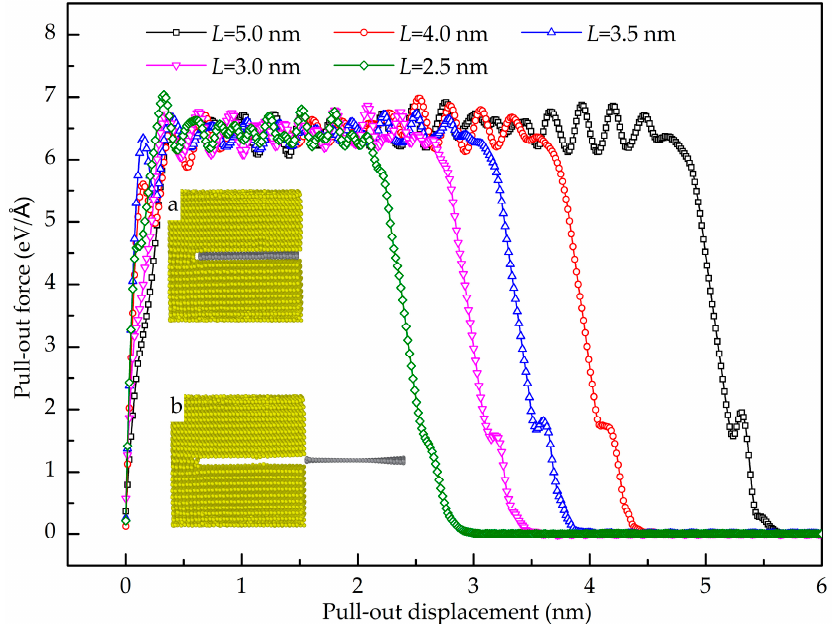
Figure 13. Pull-out force-displacement curves for the Gr/Al composites with different embedded length of graphene and the structural deformation diagram at different stage.